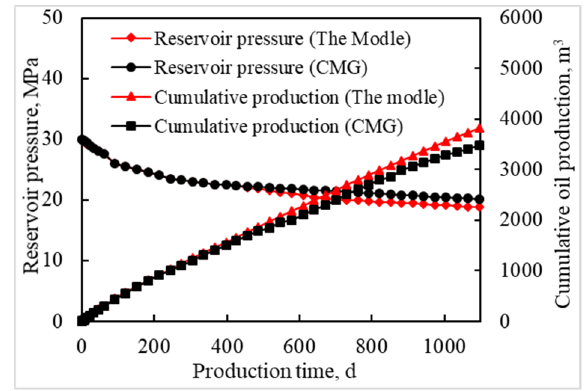
Figure 7. The calculation results of the model and CMG.